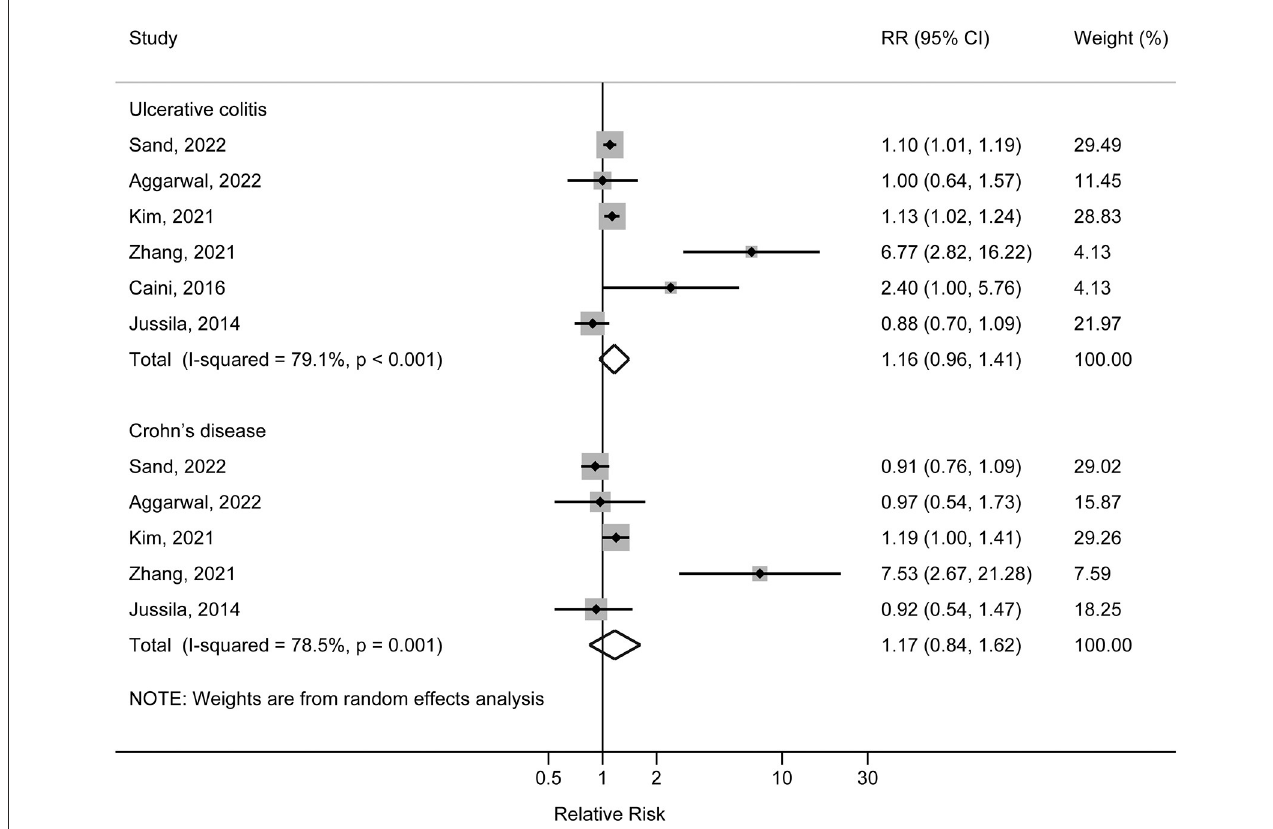
FIGURE2 Forest plot of associations of ulcerative colitis and Crohn’s disease with risk of Alzheimer’s disease.